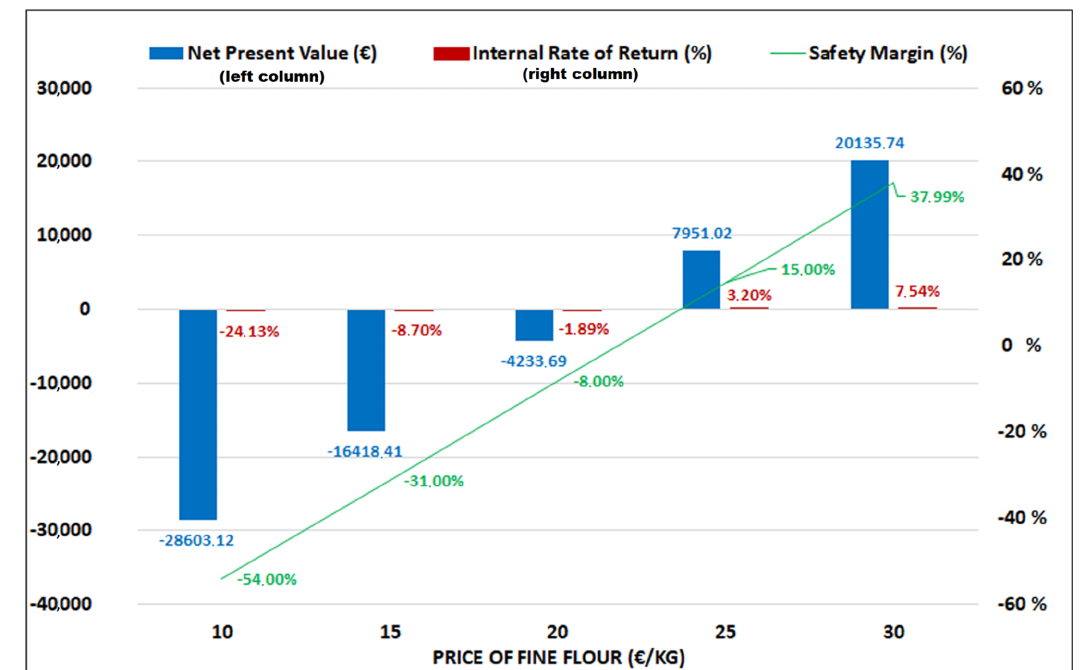
Forests 2021 , 12 , x FOR PEER REVIEW